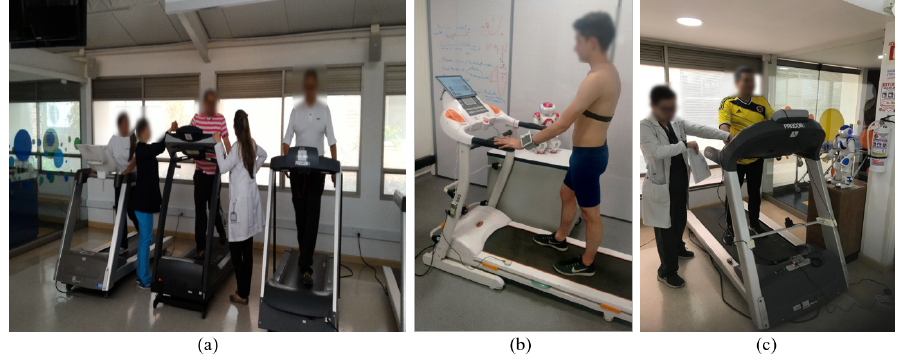
Figure 2. Social robotic companion in CR. ( a ) Exploration of the exercise session environment was carried out as a first stage. ( b ) The system design and performance were evaluated under laboratory conditions with a healthy user. ( c ) A pilot study was conducted with four patients under clinical conditions during the first four